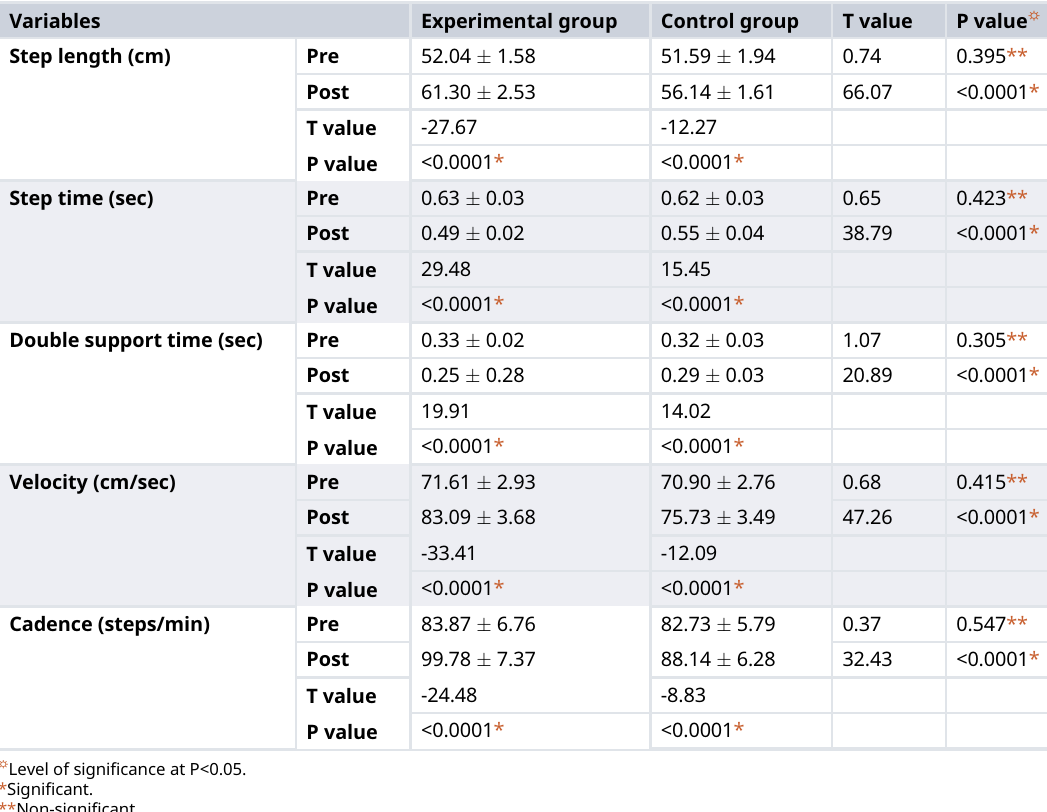
(Table 2). The mean values of gait parameters obtained at the baseline and post-treatment assessments were significantly Table 2. Pre and post-treatment mean values of gait parameters within each group and between groups. Variables